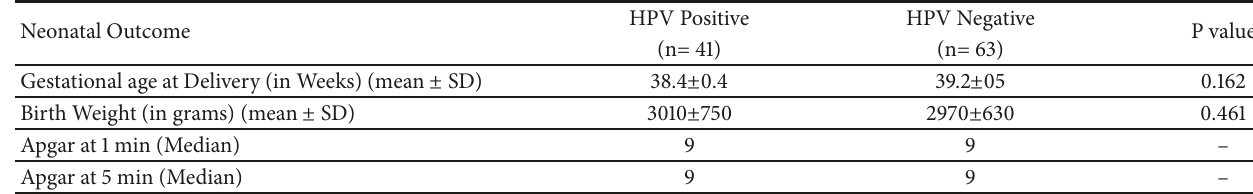
Table 3: Neonatal outcome in HPV positive versus negative